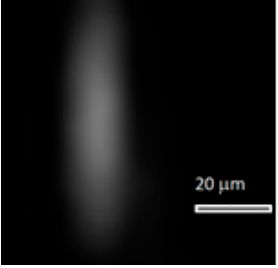
Figure 9. Experimentally measured point spread functions (PSFs; interpolated by 5.5 × 5.5 µm pixels) at 35 °C without optical scheme adjustment.